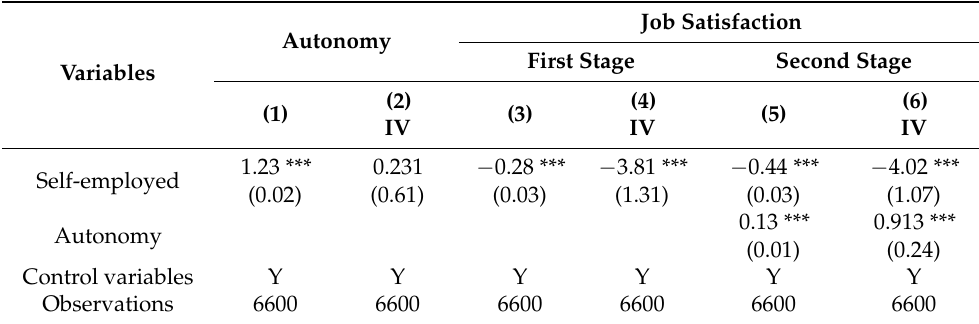
Table 6. 2SLS regression results of the effect of self-employment on job satisfaction mediated by autonomy.